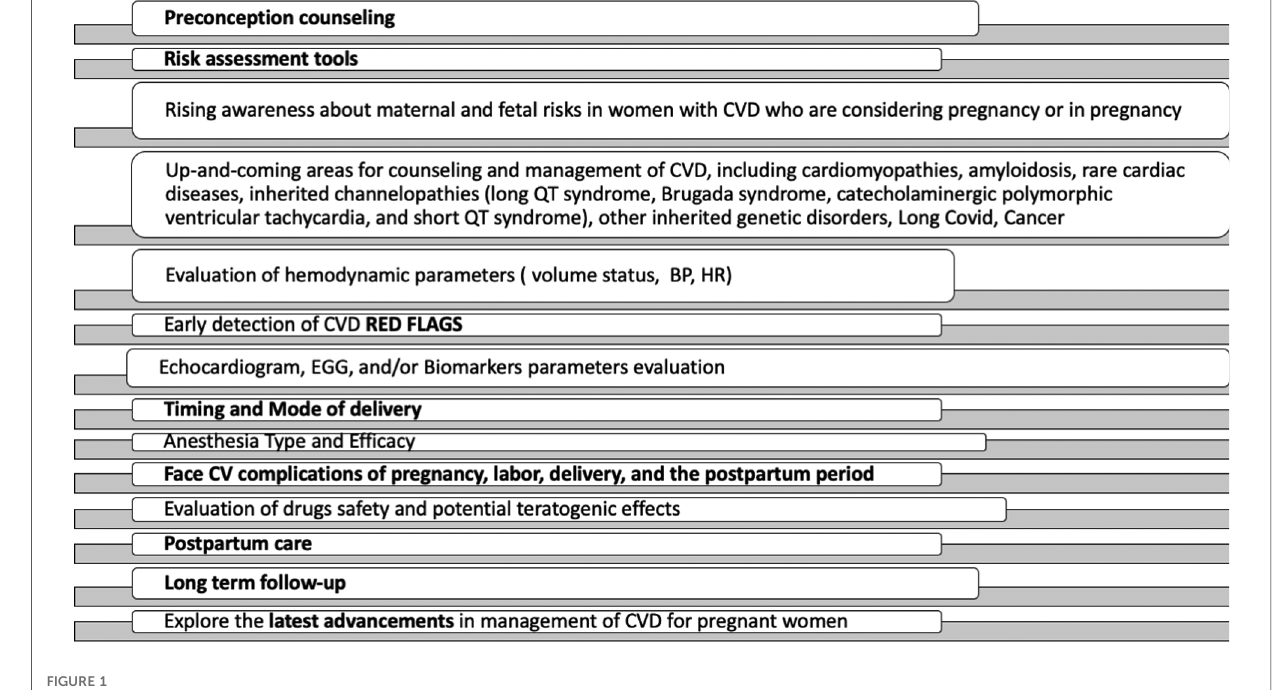
FIGURE 1 Pregnancy heart team: present and future directions. CVD, cardiovascular diseases; BP, blood pressure; HR, heart